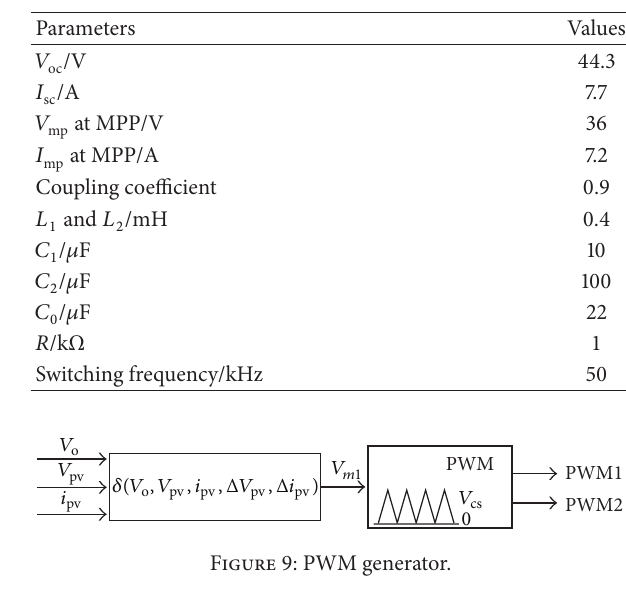
Table 1: The main parameters.